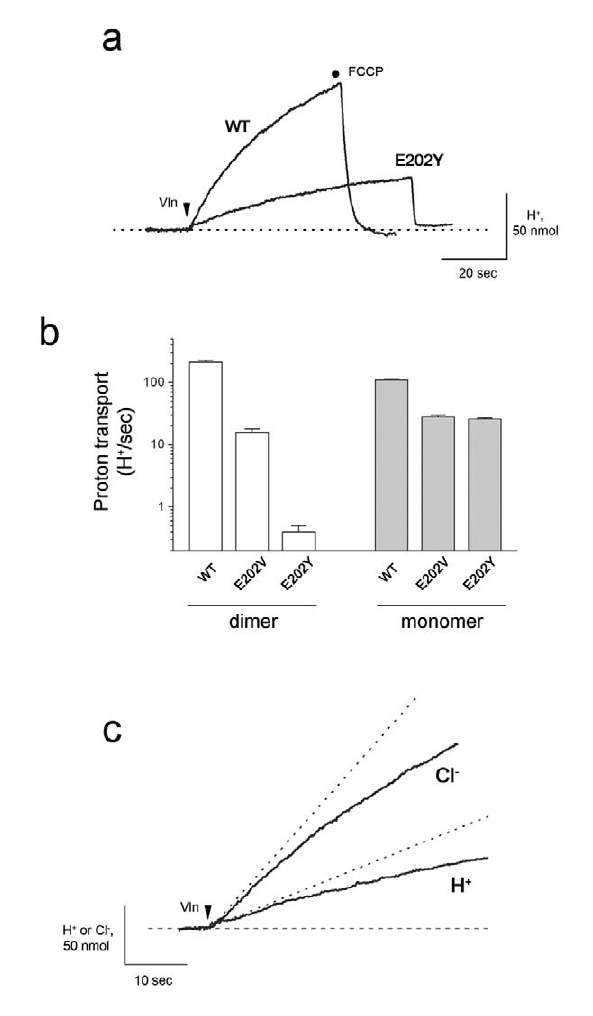
Figure 5. Test of E202 mechanism in a monomeric transporter. Effects of the E202Y mutation on transport were tested on a monomeric variant of CLC-ec1 in which a double-mutant (I201W/I422W) disrupts the homodimer interface [8]. Rigorous, complete monomer formation requires phosphatidylcholine/phosphatidylglycerol liposomes, in which transport rates are 2–4-fold slower than with E. coli phospholipids. (a) Representative H + transport traces for WT and E202Y on the monomeric background construct. (b) Comparison of inhibitory effect of E202Y substitution on H + uptake by dimeric versus monomeric transporters. (c) Cl 2 /H + exchange stoichiometry (3.1, Table S2) for monomeric E202Y was determined from initial rates (dashed lines).